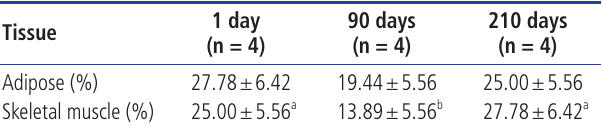
Table 2. Methylation status of the UCP3 gene in Putian Black pig at different ages Tissue